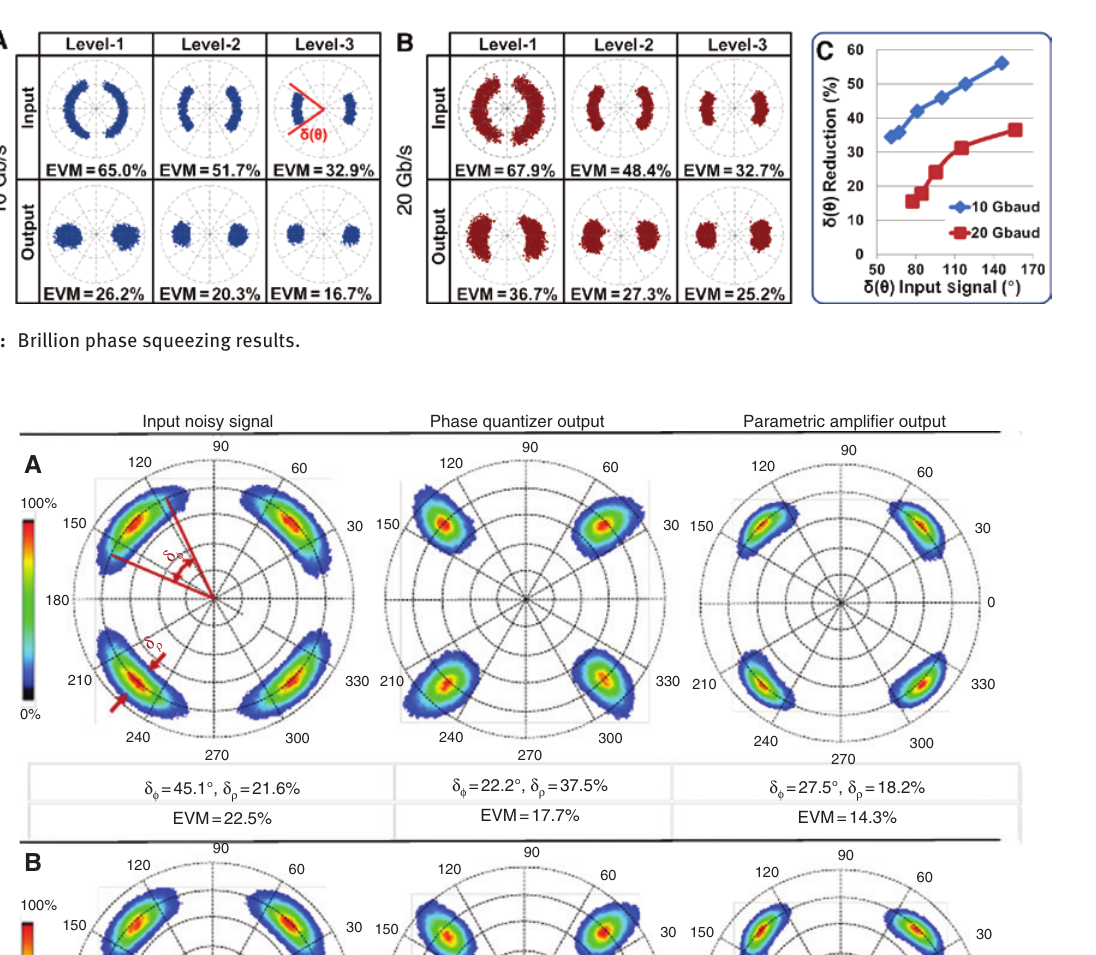
Figure 25: Brillouin phase squeezing system design.